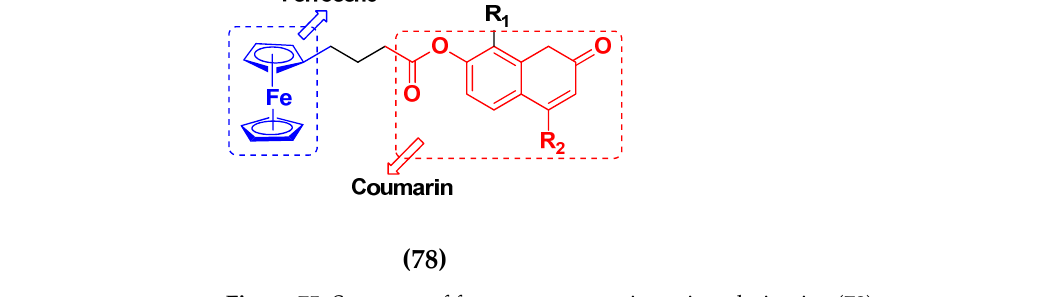
Table 64. In vitro cytotoxic activities of ferrocene ‐ coumarin hybrid compounds 78 ( a – d ). Figure 75. Structure of ferrocene ‐ coumarin moiety derivative ( 78 ).